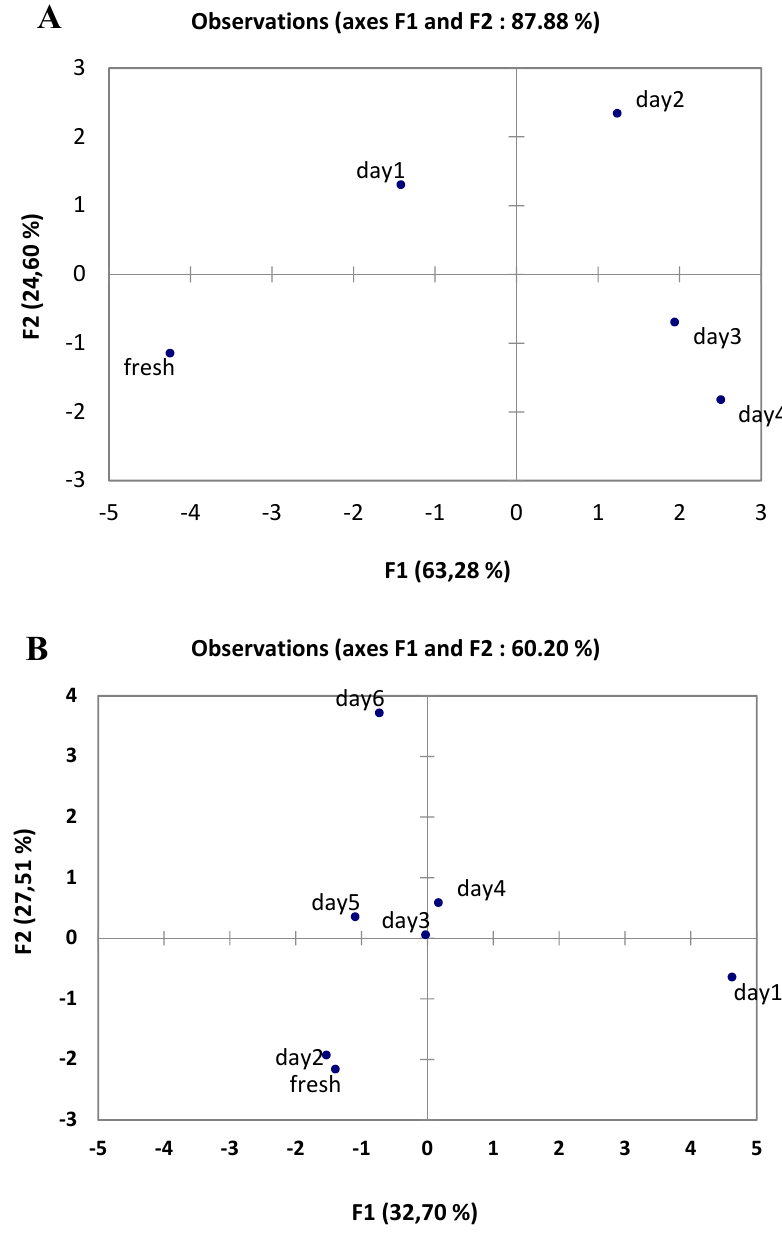
Figure 2. Plot of the two principal components of the principal component analysis (PCA) of tchapalo stored at ( A ) ambient temperature (28 to 30 °C) for four days and ( B ) 4 °C for six days.